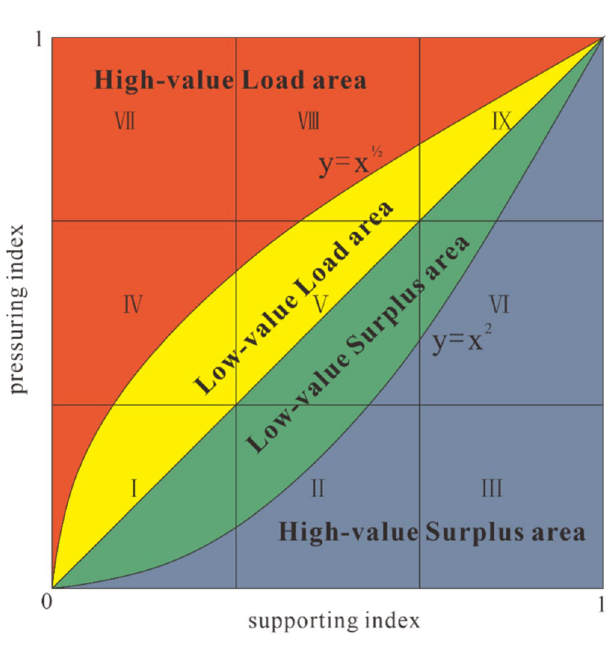
Figure 2. Schematic diagram of support index and pressure index zoned states and coupling curves.